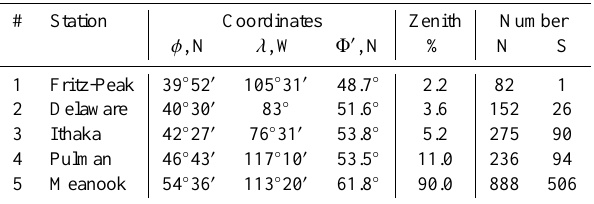
Table 1. Auroral observatories during the IGY with their coordi- nates (geographic latitude φ and longitude λ as well as the corrected geomagnetic latitude Φ 0 ; appearance of auroras in the zenith in per cent of the total and the number of observations northward (N) and southward (S) of the